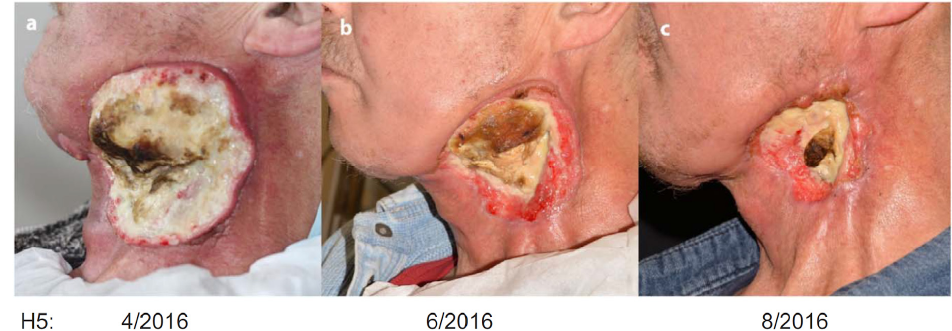
Figure 7. The clinical effect of CAP treatment on a patient (H5) with locally advanced head and neck cancer. Reprinted with permission from Ref. [99]. 2017, Elsevier GmbH. The patient’s therapeutic effect was recorded in April/2016 ( a ), June/2016 ( b ), and August/2016 ( c ), respectively.